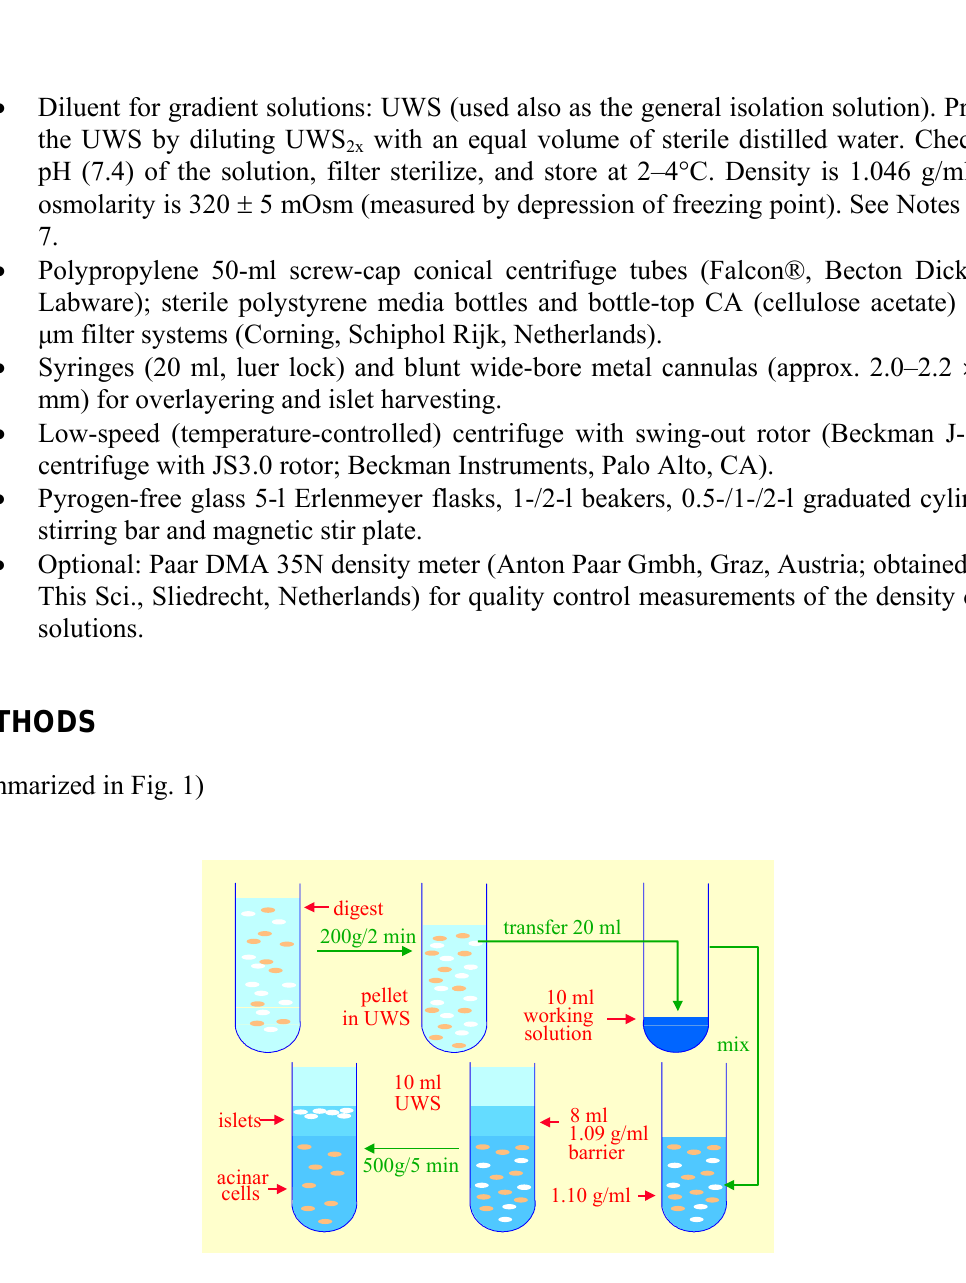
FIGURE 1. Islet purification flow